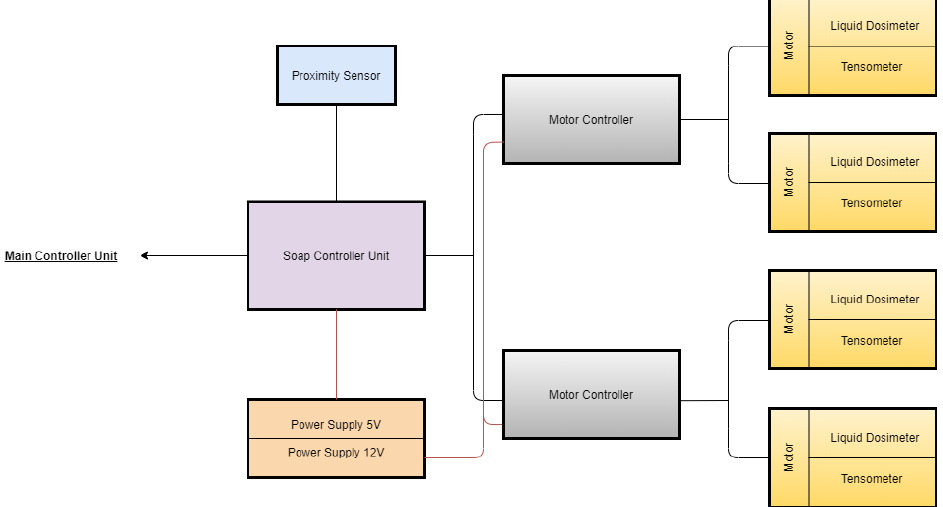
Figure 7. A concept of the soap controller unit of the interactive shower panel.